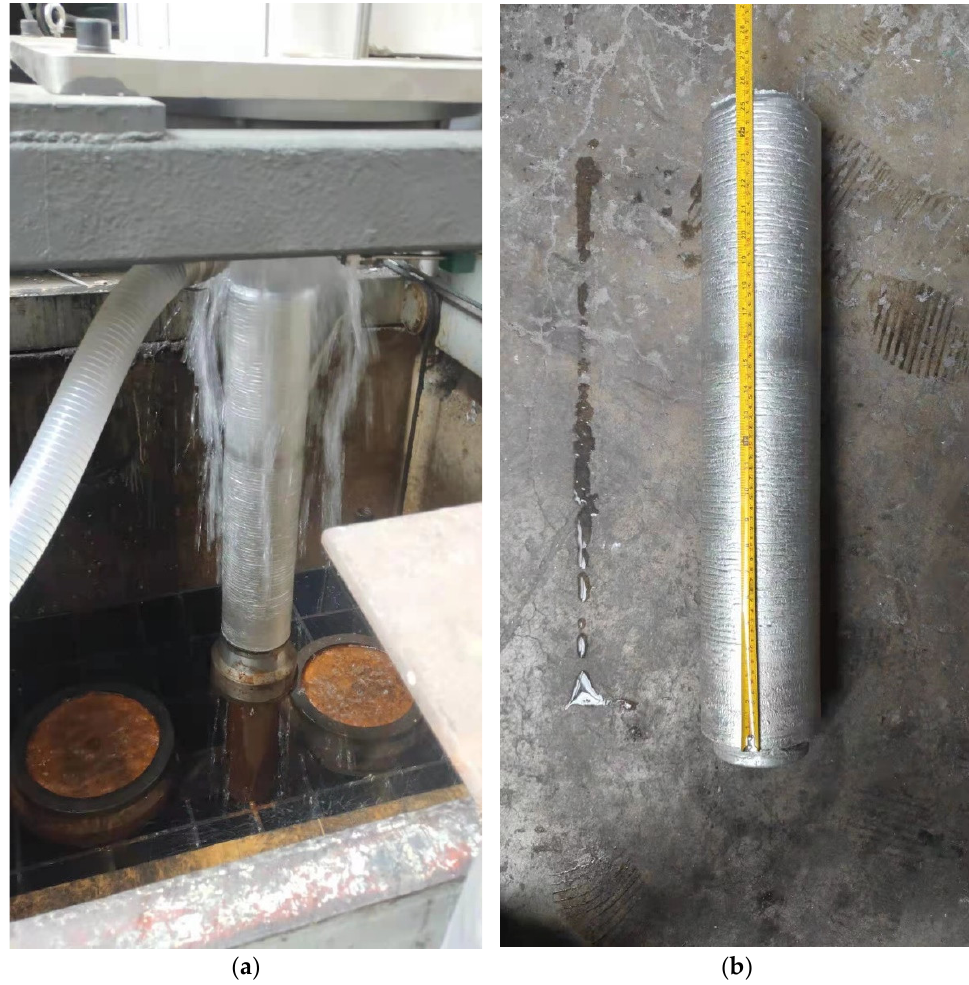
Figure 3. ( a ) Semi-continuous casting process, and ( b ) resulting AlSn20Cu alloy ingot.